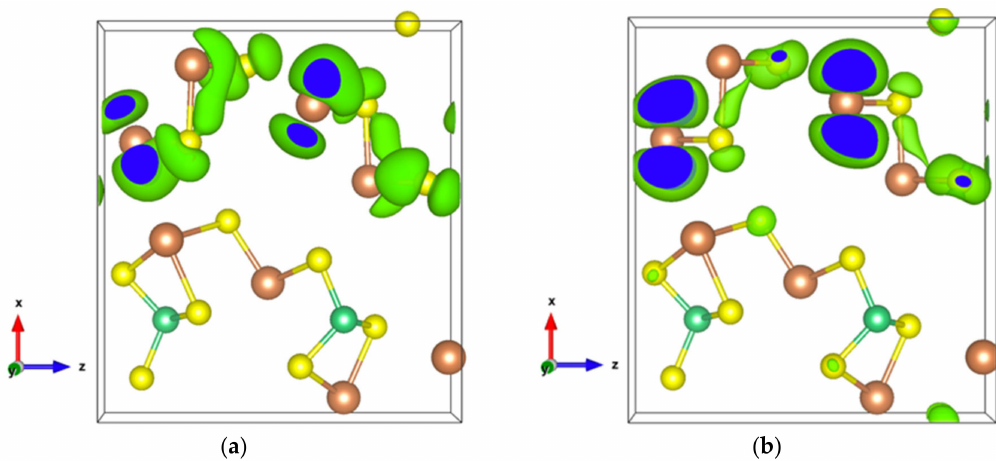
Figure 7. ( a ) Electronic density of Sb 2 S 3 Be 2 for the highest occupied orbital with an isosurface of 0.001 electrons / bohr 3 ; ( b ) Electronic density of Sb 2 S 3 Be 2 in the energy range comprising the top two valence orbitals with an isosurface of 0.003 electrons / bohr 3